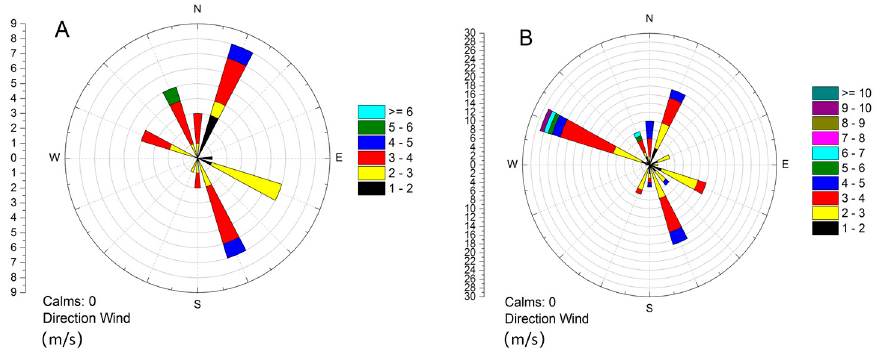
Figure 9. The wind roses of the six pollution periods ( A ) and the whole sampling period ( B ) at the autumn–winter season of 2017–2018.